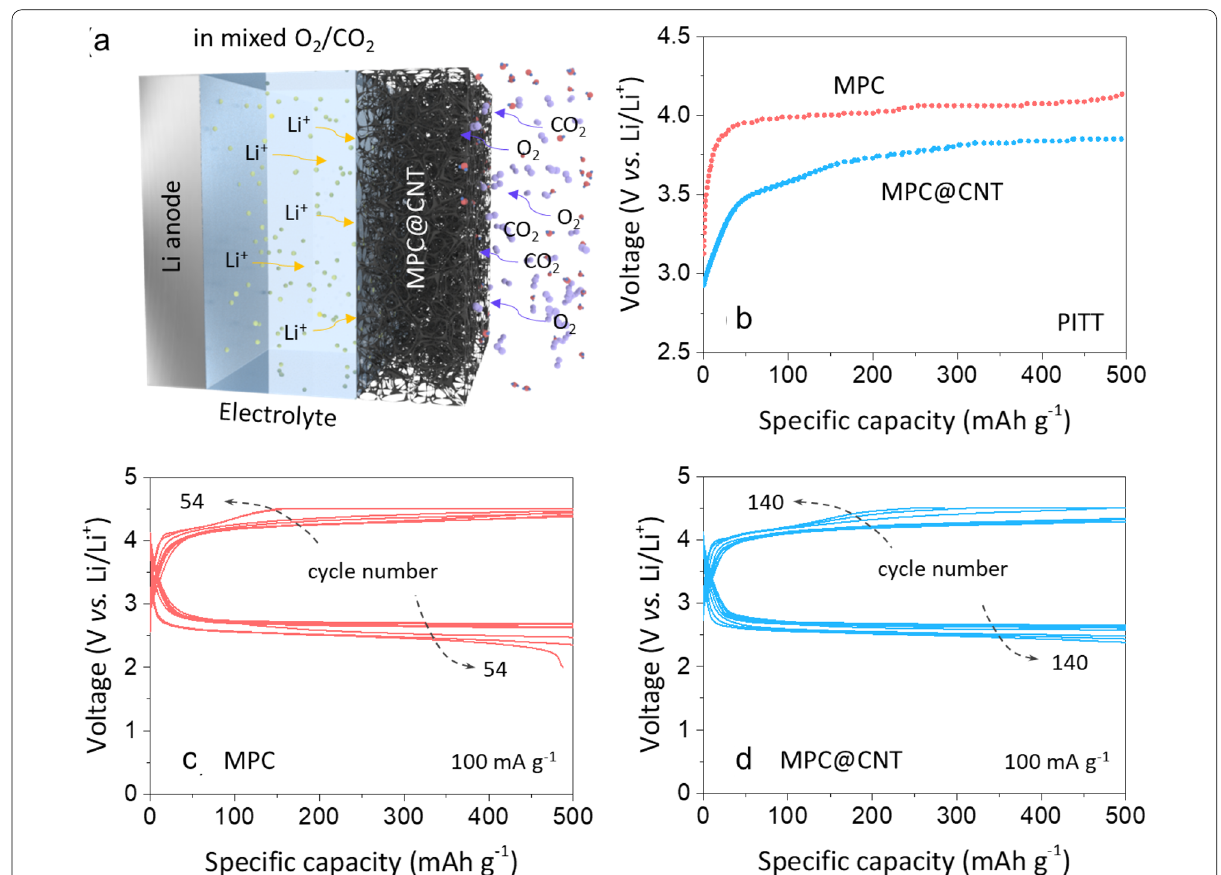
Fig. 5 a Schematic diagram for the LOB operating in a mixed O 2 /CO 2 atmosphere. b Quasi‑equilibriium charge potential profiles of the LOBs with MPC and MPC@CNT obtained via PITT experiments. Discharge–charge curves of the LOBs with c MPC and d MPC@CNT during cycling at 100 mA g −